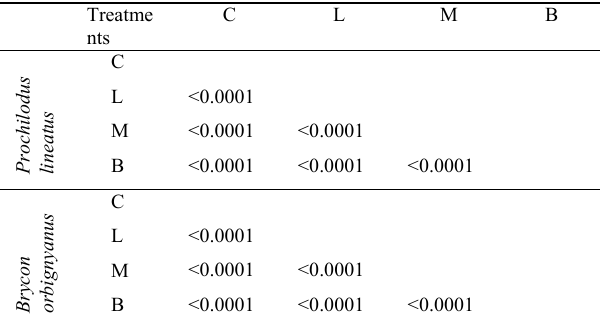
Table 4. P-values of the Discriminant Analysis among the treatments [C = control; L = logs; M = macrophytes; and B = both (logs+macrophytes)] for Prochilodus lineatus and Brycon orbignyanus .